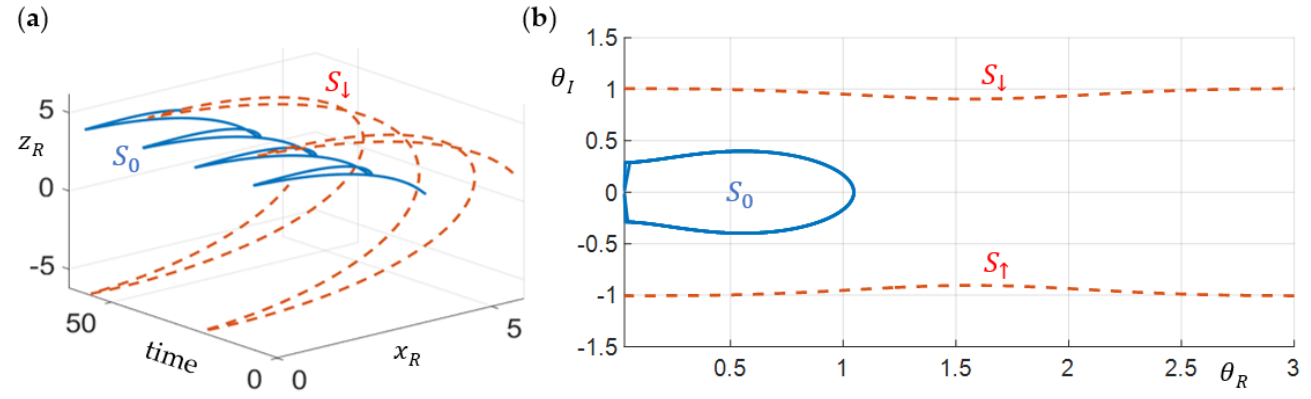
Figure 5 . ( a ) The time evolution of the electron’s complex trajectories of the 2p state in the real x - z plane. The solid-blue line and dashed-red line represent the complex trajectories with initital positions (𝜌(0), 𝜃(0)) = (4,𝜋 3⁄ ) ∈ 𝑆 0 and (𝜌(0),𝜃(0)) = (4,𝜋 3⁄ ± 𝑖) ∈ 𝑆 ↓ (𝑆 ↑ ) , respectively; ( b ) The electron’s trajectories in the complex 𝜃 -plane.